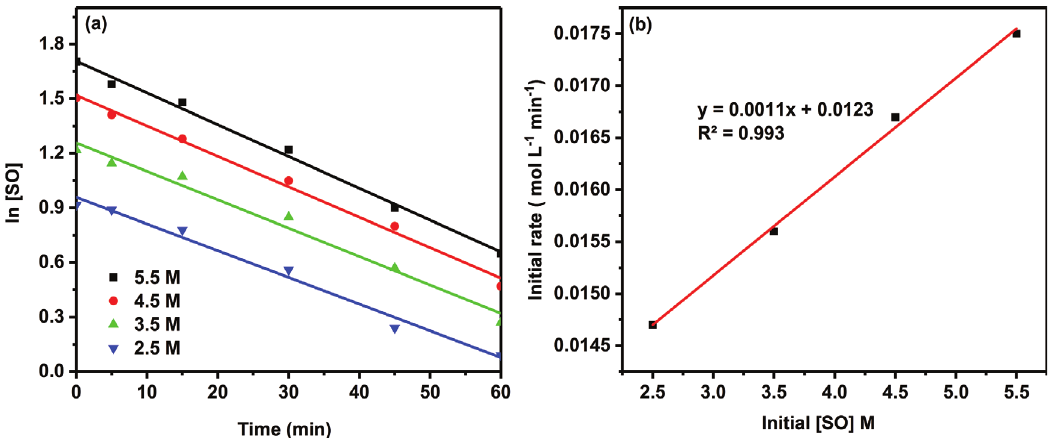
Figure 8: (a) Curve fittings of ln [SO] as a function of time (min) over the range of SO (2.5-5.5) M (b) Plot showing a linear dependence of initial reaction rate (mol L –1 min –1 ) against initial epoxide concentrations [SO] M (reaction conditions: 6.5 mM ZnBr and 6 bar p (CO )). 2